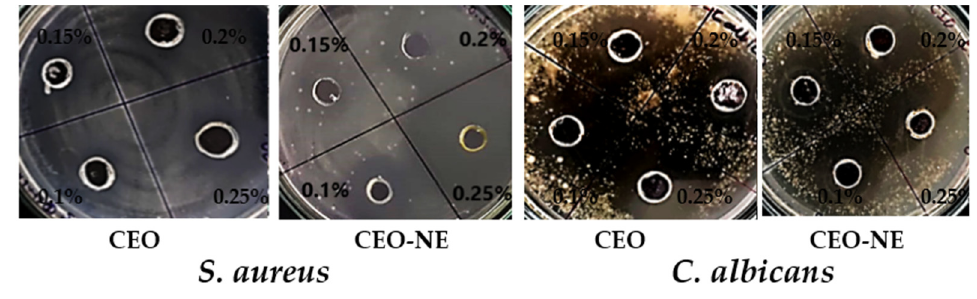
Figure 3. Antimicrobial activity of citronella essential oil (CITEO) and its nanoemulsion (CITEO-NE) against S. aureus . and C. albicans .